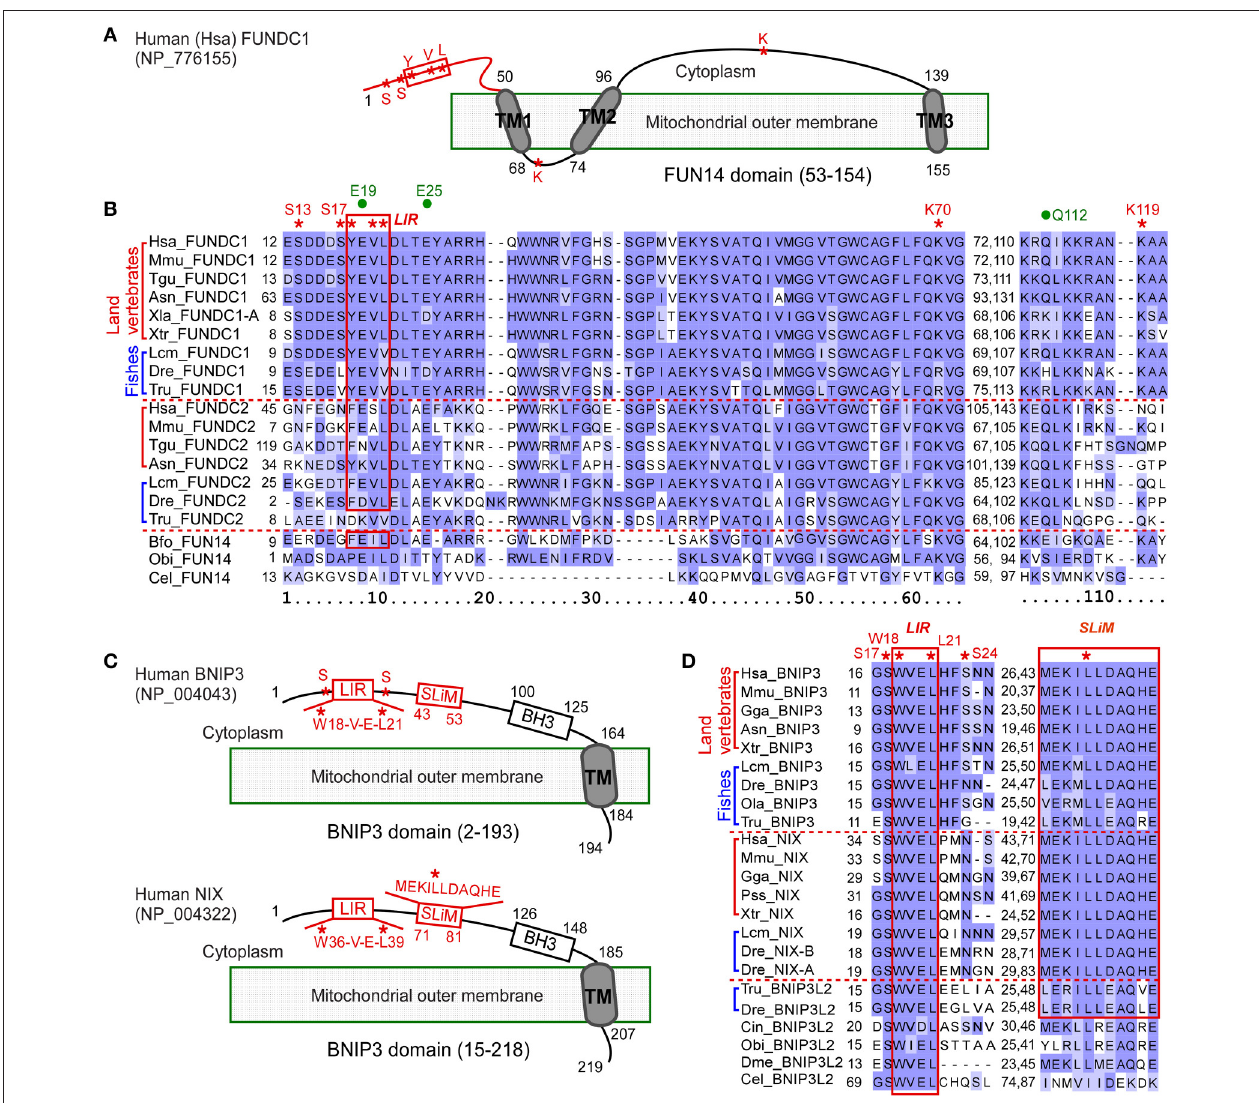
FIGURE 1 | Multiple sequence alignment of proteins containing FUN14 or BNIP3 domain in animals. (A) Illustration representing the topology of Homo sapiens FUNDC1 (NP_776155), a mitochondrial outer membrane protein. Cytosolic region is at the top of the membrane. FUN14 domain (PF04930) covers all three transmembrane (TM) domains. Red box indicates LC3 binding region (LIR, Y/W/F-x-x-L/I/V). Red asterisks indicate key phosphorylation sites (S13, S17, and Y18), conserved sites in LIR, and key sites (K70, K119) for interacting with OPA1 and MARCH5. (B) Alignment of FUN14 domain-containing proteins in representative metazoan species of six land vertebrates, three fishes and three invertebrates. The LIR motif is enclosed within a red box. Red asterisks indicate biologically important residues as labeled in (A) . Three green dots indicate predicted functionally divergent sites (see Materials and Methods). (C) Topology of two other mitochondrial outer membrane proteins, BNIP3 (NP_004043) and its homolog NIX (NP_004322), in human. Both proteins contain a BNIP3 domain (PF06553), which covers a BH3 domain and a carboxyl-TM domain. They localize to the mitochondrial outer membrane through their C-terminal TM domains while their N termini are exposed to the cytosol. A short linear motif (SLiM) essential for NIX activity and an LIR motif are labeled with red boxes. The SLiM comprises a triplet of hydrophobic amino acid residues at its center and charged residues on each side of the triplet. Red asterisks indicate conserved sites in LIR, key phosphorylation sites (S17 and S24) in BNIP3, and the central leucine (Leu) residue in the hydrophobic triplet of SLiM in NIX. (D) Alignment of LIR motif and SLiM of BNIP3 and NIX in representative metazoan species. The LIR motif, W(18)-V-E-L(21), in human BNIP3 and its conserved sequences are enclosed within a red box. The SLiM are conserved in vertebrates and are enclosed within a red box. Red asterisks indicate key sites, as labeled in (C) . Ola indicates O. latipes and Tru indicates T. rubripes . Information on other species is listed in Table 1 . The alignments in (B,D) were colored according to BLOSUM62 score in Jalview (Waterhouse et al., 2009).